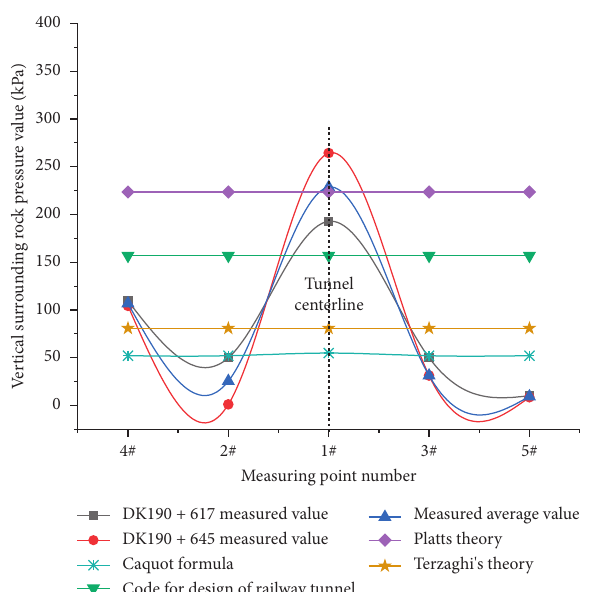
Figure 9: Pressure distribution of vertical surrounding rock at each measuring point.